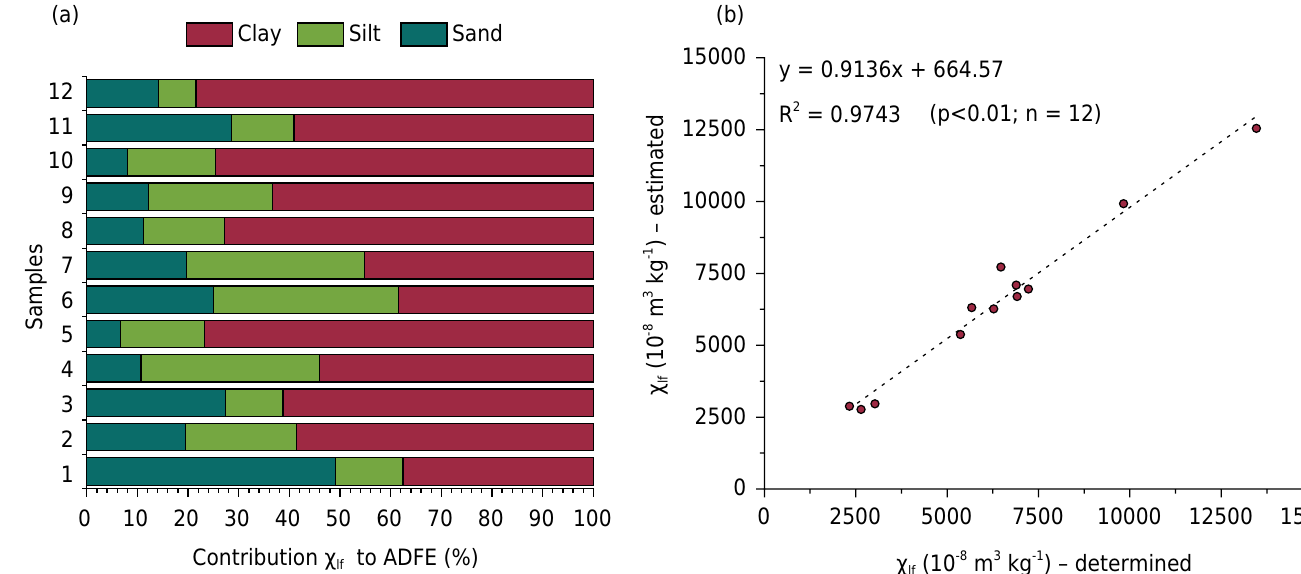
Figure 9. Estimated contribution of sand, silt, and clay fractions to the χ lf of ADFE (a), and correlation between estimated and determined